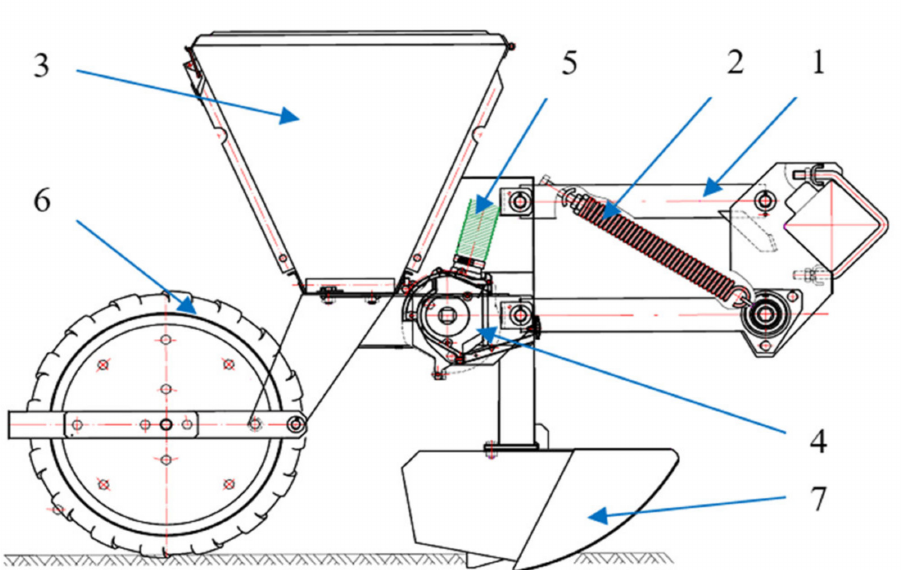
Figure 1. Scheme of the studied row unit: (1) frame; (2) springs; (3) seed supply box; (4) seed meter; (5) vacuum channel flexible tube; (6) soil compaction wheel; and (7) furrow